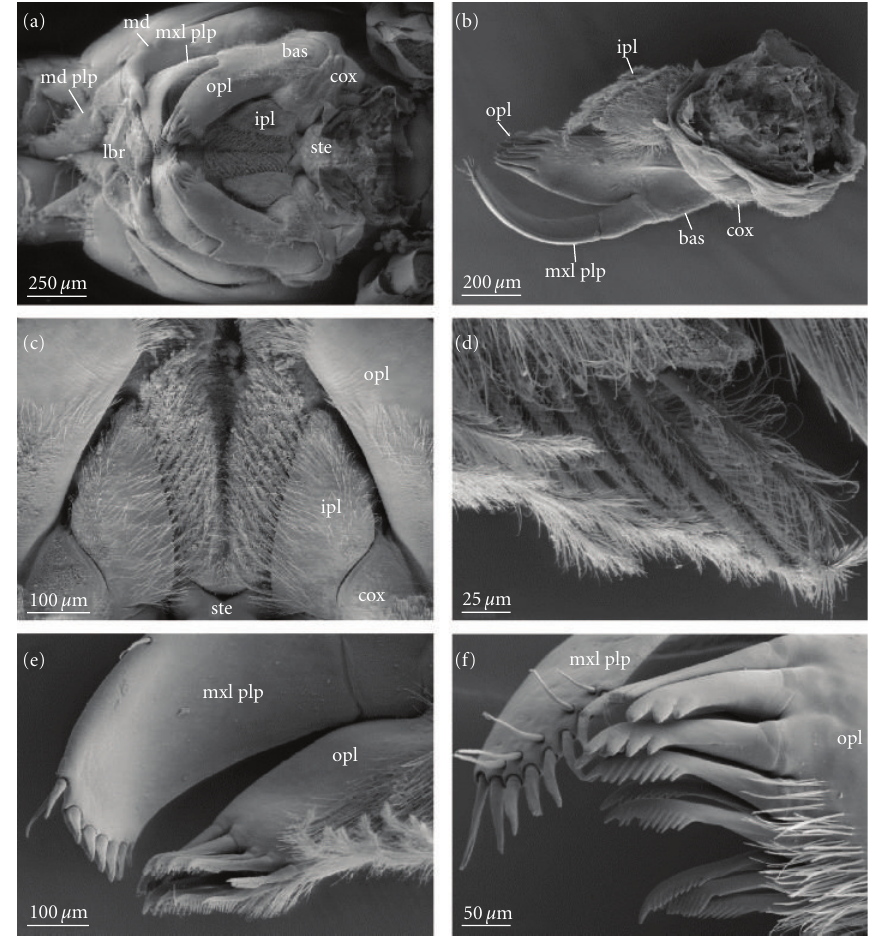
Figure 11: SEM images of maxillulae of Gammarus pulex : (a) maxillulae in situ in posterior view; (b) left maxillula in anterior view; (c) inner plates of maxillulae in situ in posterior view; (d) median setation of inner plate of left maxillula in medio-posterior view; (e) outer plate and palp of right maxillula in anteromedian view; (f) outer plate and palp of left maxillula in posterior view. Abbreviations other than in previous figures: md plp: palp of mandible; mxl plp: palp of maxillula.